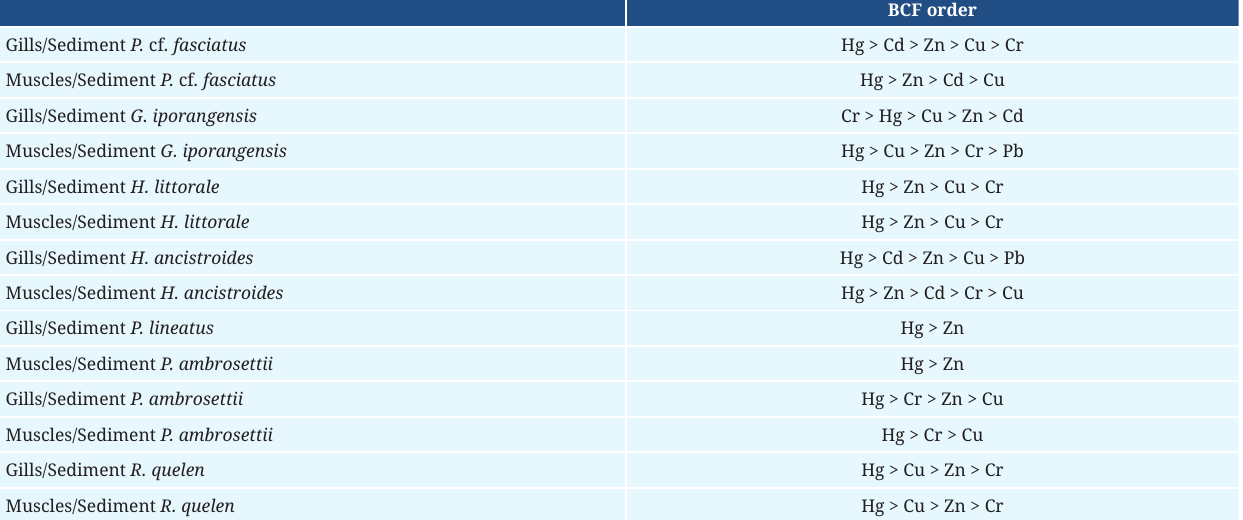
TABLE 5 | The bioconcentration factor order obtained for the studied